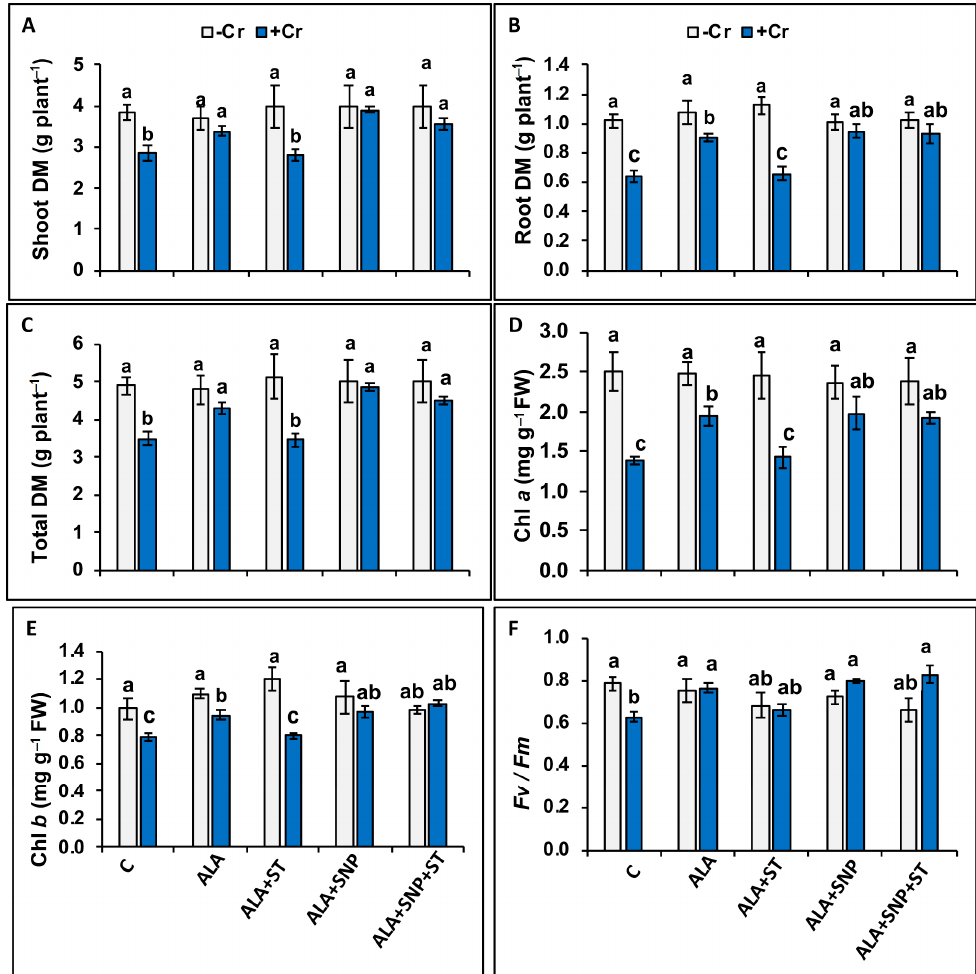
Figure 2. Shoot ( A ), root ( B ), total dry mass (DM) ( C ), chlorophyll a ( D ), chlorophyll b ( E ), and maximum efficiency of photosystem II photochemistry (F v /F m ) ( F ) in Cr-treated (+Cr) and non-treated ( − Cr) tomato seedlings, sprayed with 20 mg L − 1 5-aminolevulinic acid (5-ALA) or 0.1 mM sodium tungstate (ST) + 5-ALA, 5-ALA + 0.1 mM sodium nitroprusside (SNP), or 5-ALA + SNP + ST. Data are means ± S.E, different lower-case letters on bars reflect that mean values differ significantly at p ≤ 0.05.